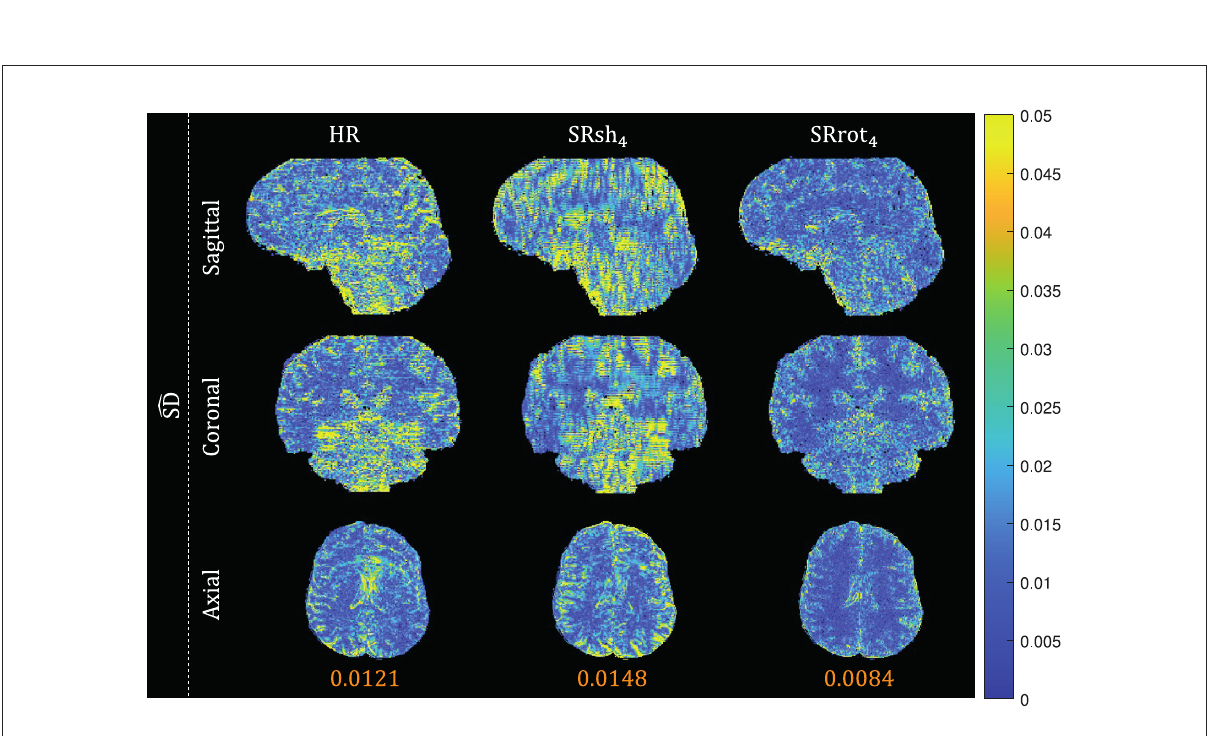
FIGURE7 Real data results: SD maps. The views from orthogonal planes of the SD map for each protocol are shown, and the median value computed inside a brain mask for each SD map is